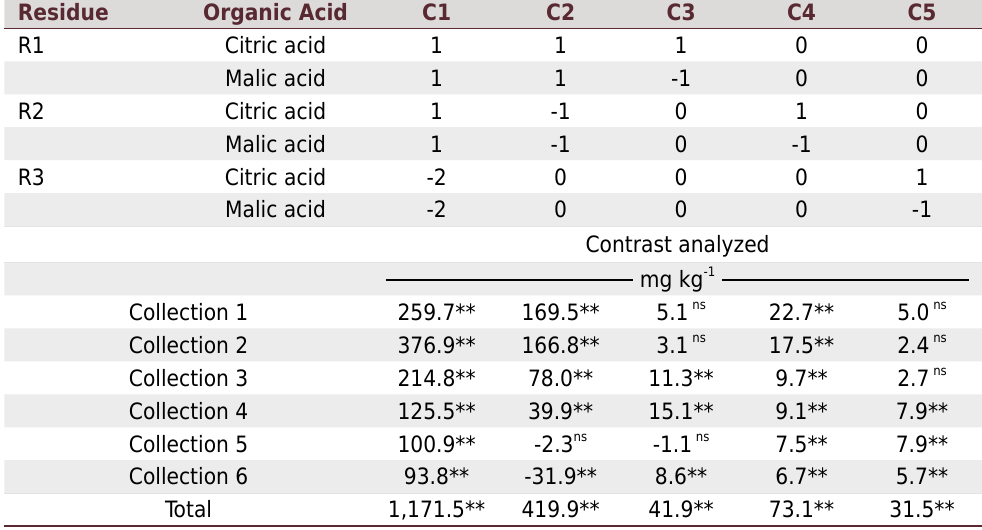
Table 3. Orthogonal contrasts (C) of the amount of potassium extracted considering the residue (R) and organic acids, for each collection